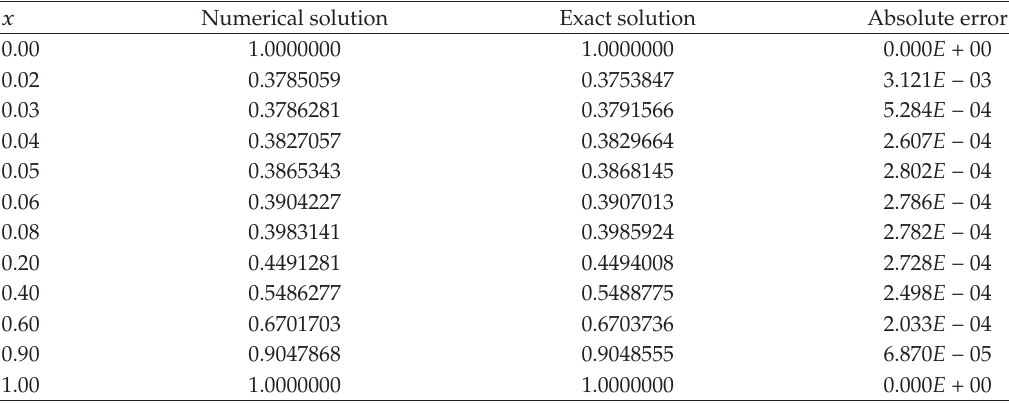
Table 2: Numerical results of Example 4.1 for ε (cid:8) 0 . 001 , δ (cid:8) 0 . 0008, N (cid:8) 100.